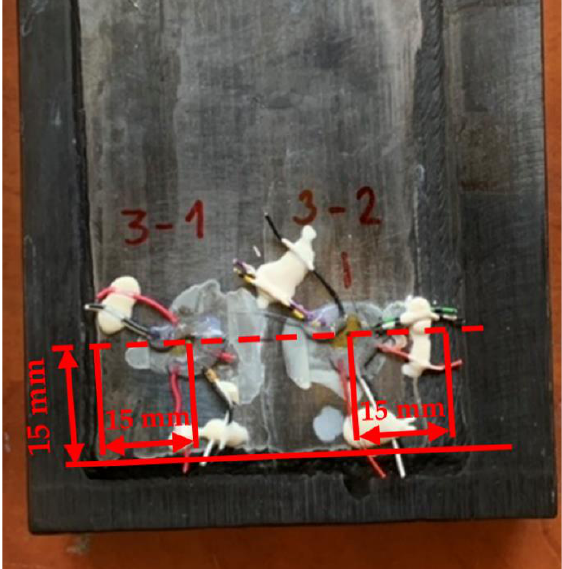
Figure 4. Sample 03 after drilling measuring locations 1 and